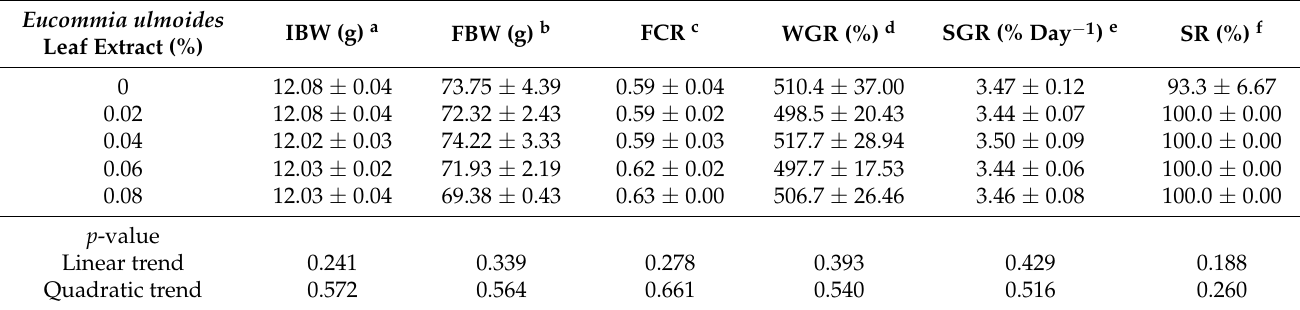
Table 4. Growth performance of the GIFT fed with different diets.